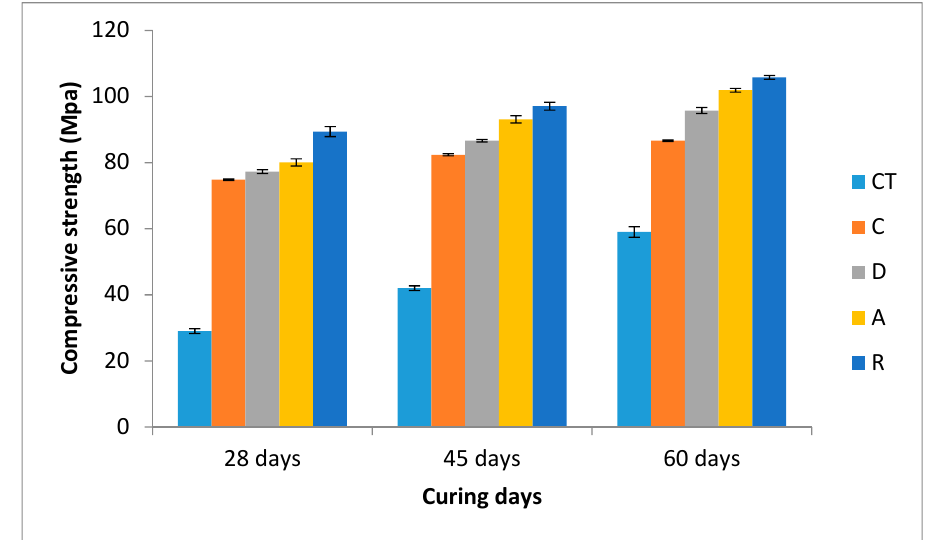
Figure 3. Compressive strength result (Legend: CT = control, C = 10% latex, D = 0.5% fiber and 10% latex, A = 1% fiber and 10% latex and R = 1.5% fiber and 10% latex.)